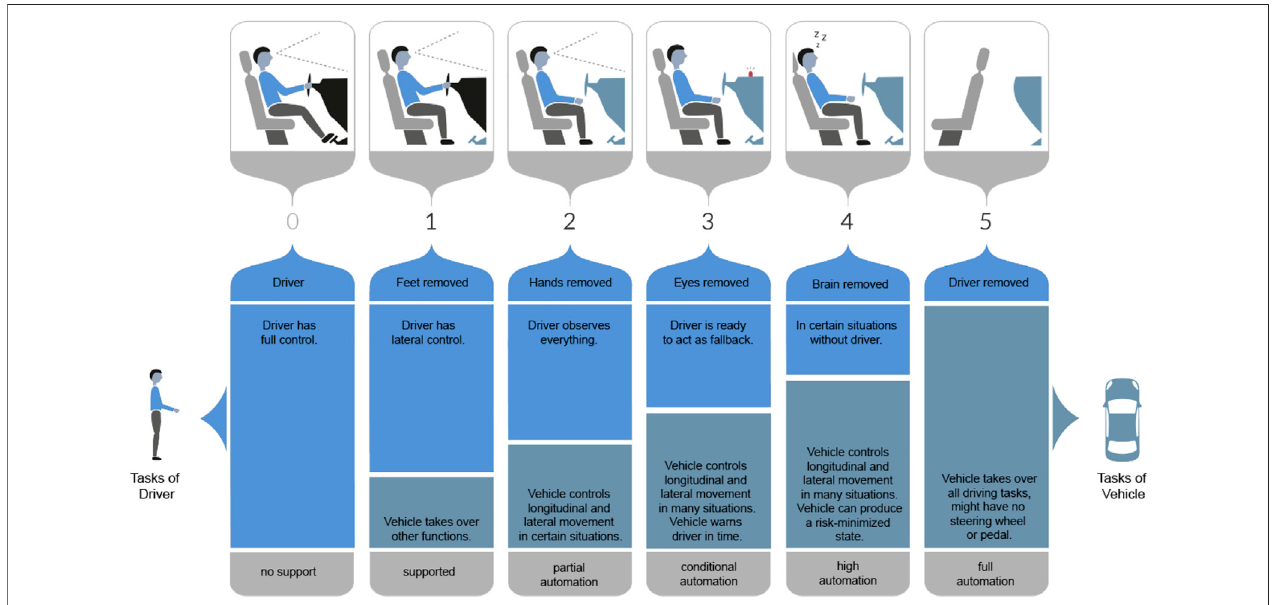
FIGURE 1 | SAE levels of vehicle automation (SAE On-Road Automated Vehicle Standards Committee, 2021).